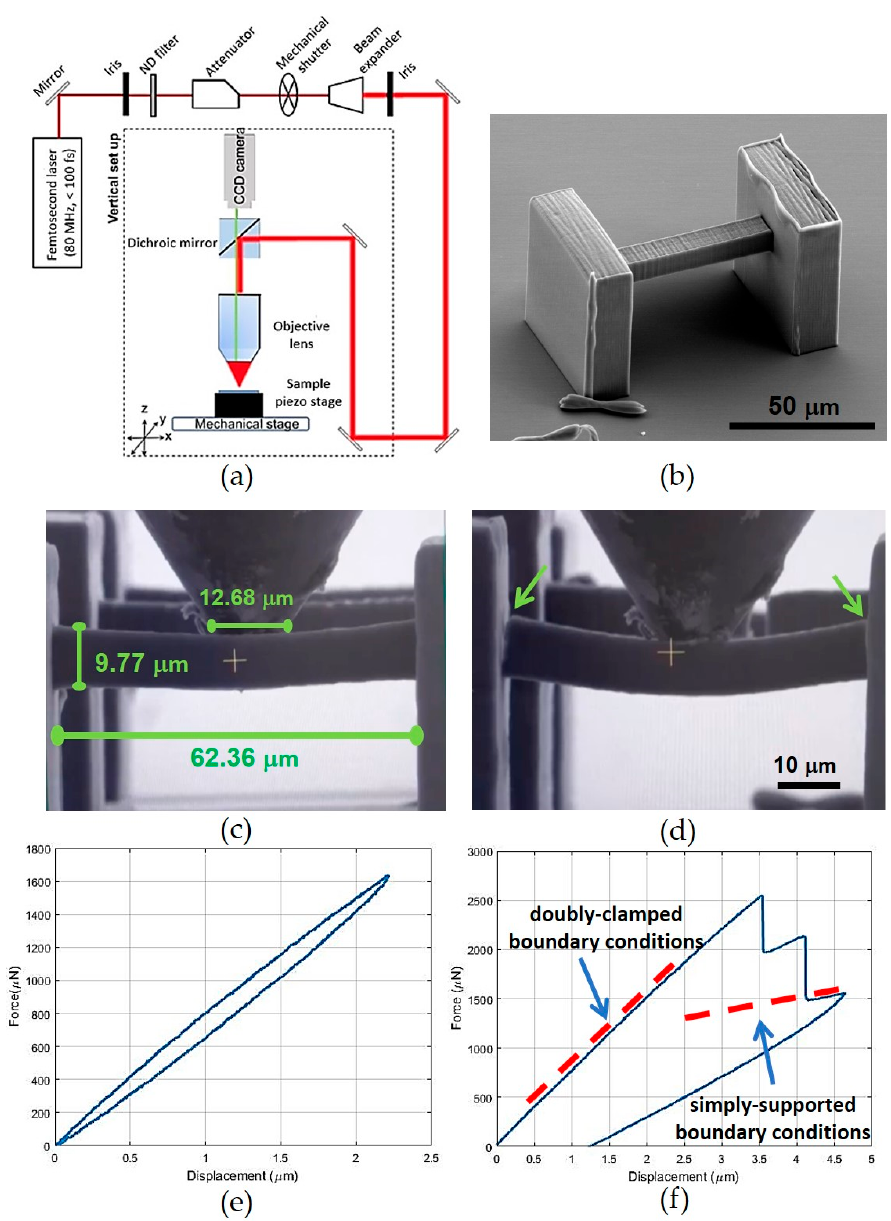
Figure 4. Experimental setup and testing to obtain the mechanical properties. ( a ) Schematic of the multiphoton lithography experimental setup [46]. ( b ) Beam structure employed for three-point bending measurements. ( c ) Beam structure at the beginning of the testing and dimensions. ( d ) Beam structure after cracking at the end sections. ( e ) A characteristic force-displacement curve obtained by three-point bending. ( f ) The force-displacement curve of a beam reaching the failure strength (cf. Video S1: Three-point